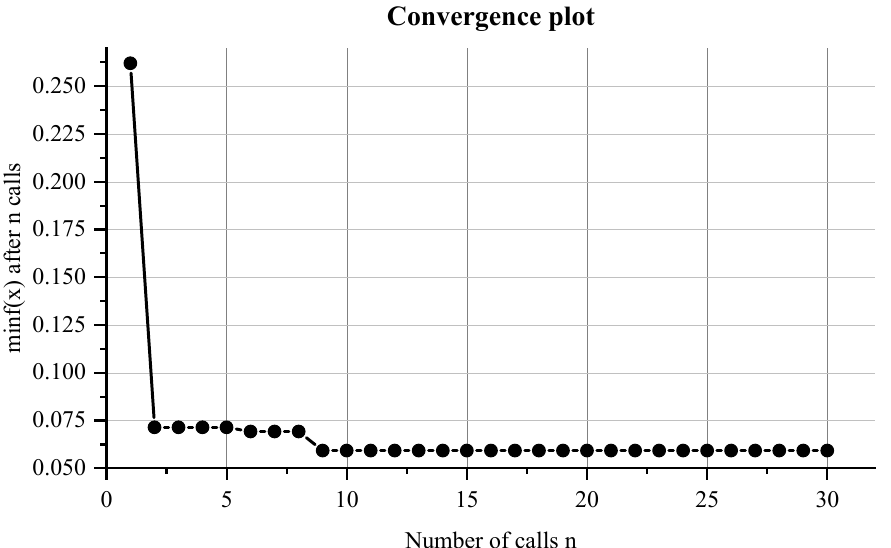
Figure 6. Convergence plot of the CNN-LSTM with the SE model by the Bayesian optimization al- gorithm.